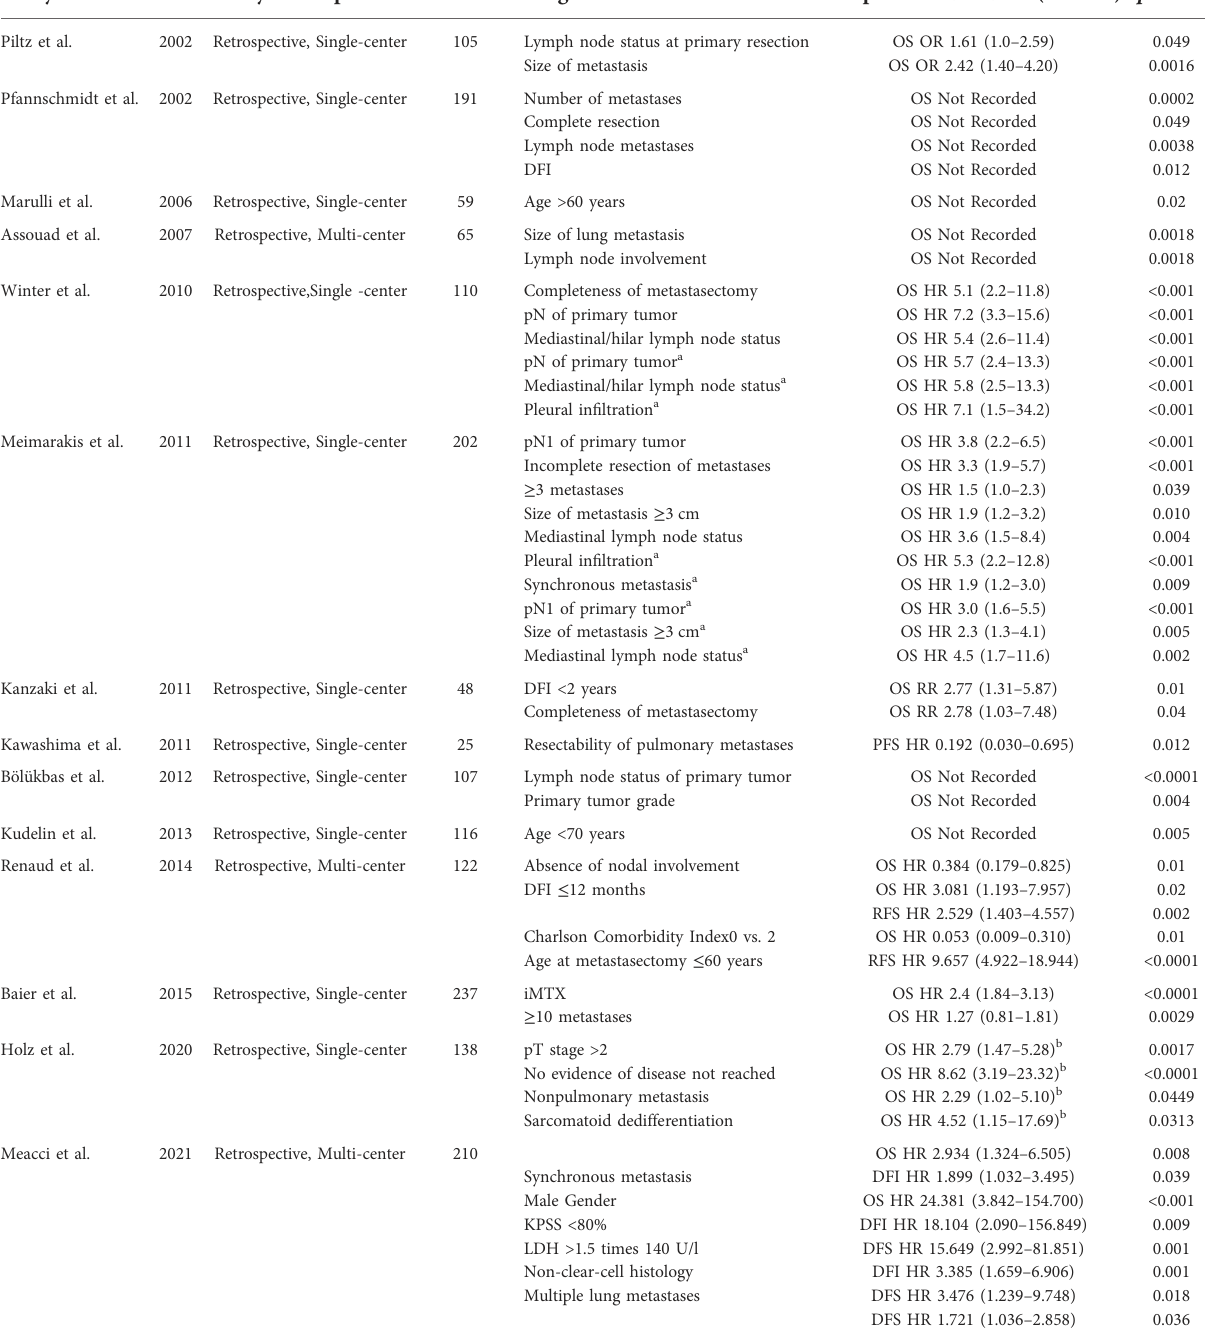
TABLE 2 Prognostic factors identi fi ed via multivariate analysis for metastatic renal cell carcinoma in patients with lung